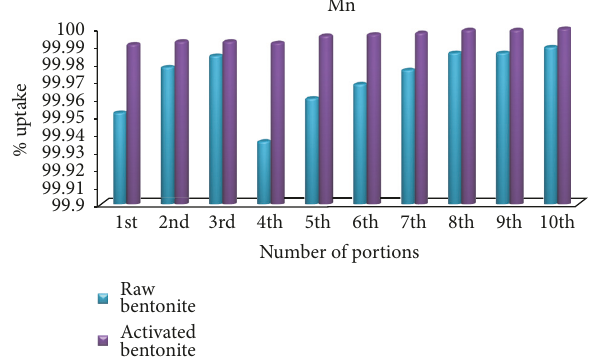
Figure 9: Percentage uptake of Mn(II) by raw and acid activated bentonite using column